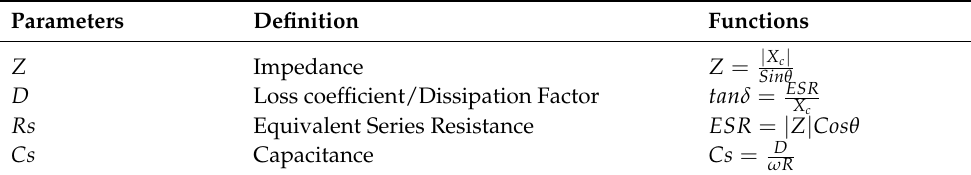
Table 3. Electrical Signal and its